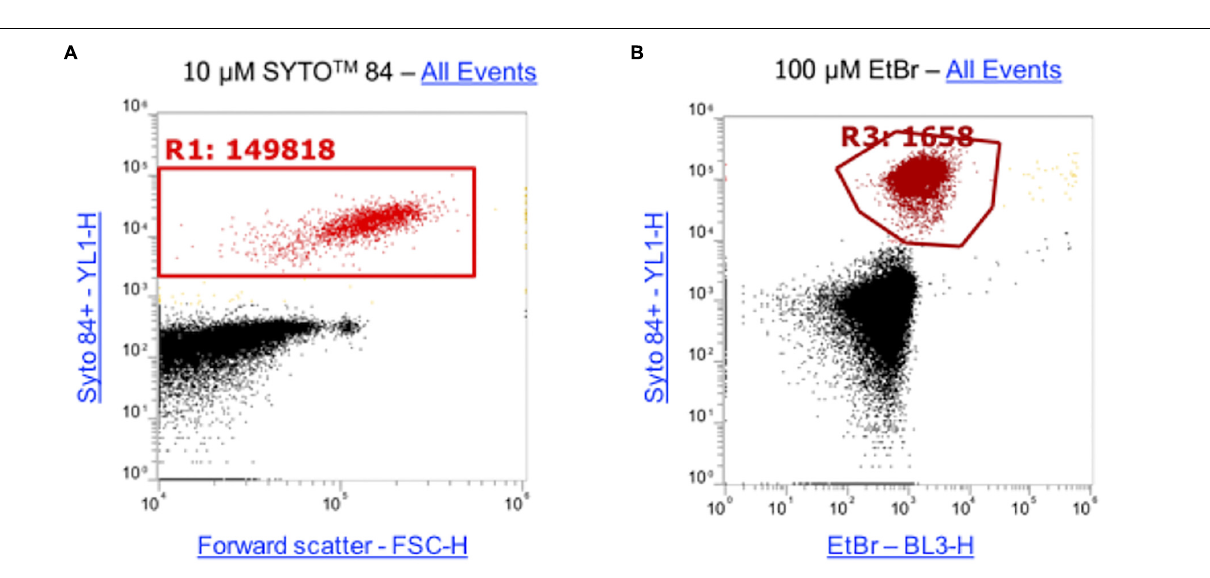
Frontiers in Microbiology |